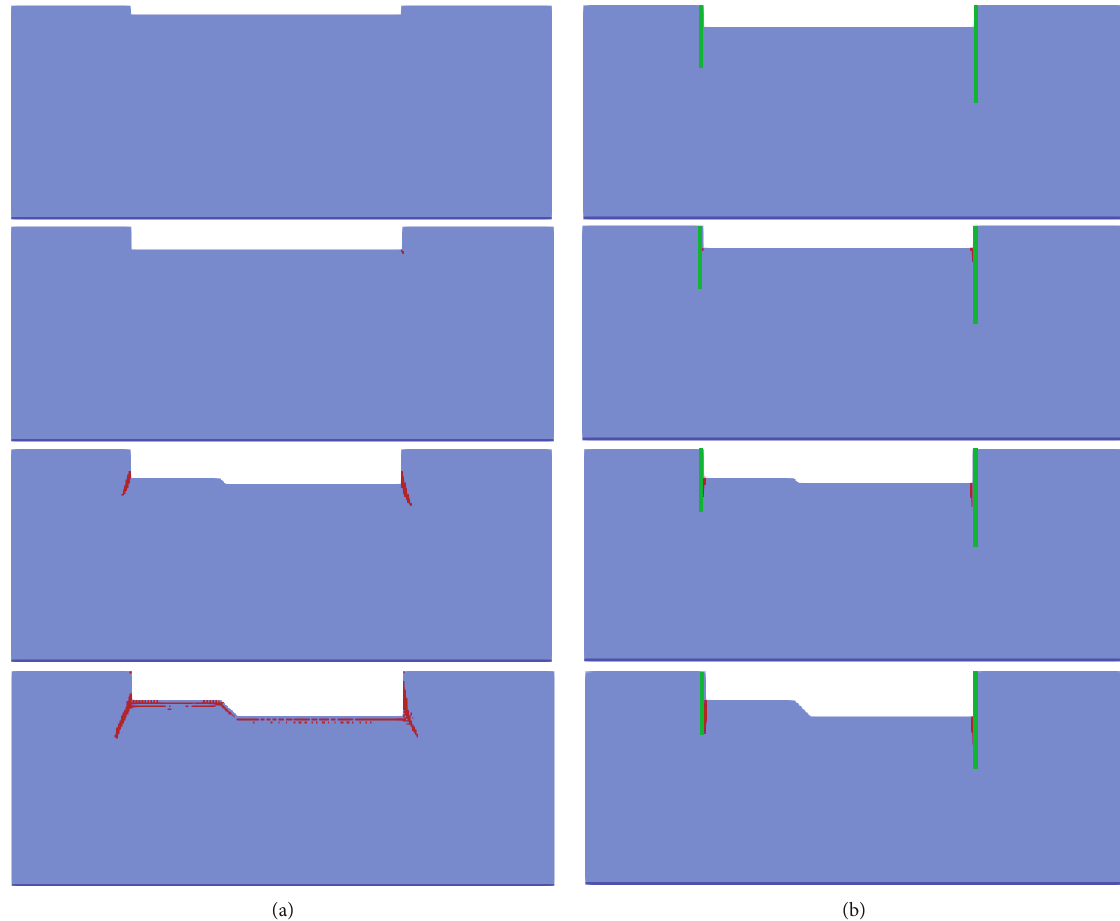
Figure 8: Progressive failure processes of foundation pit. (a) Numerical model without retaining walls. (b) Numerical model with retaining walls (the green part is the retaining